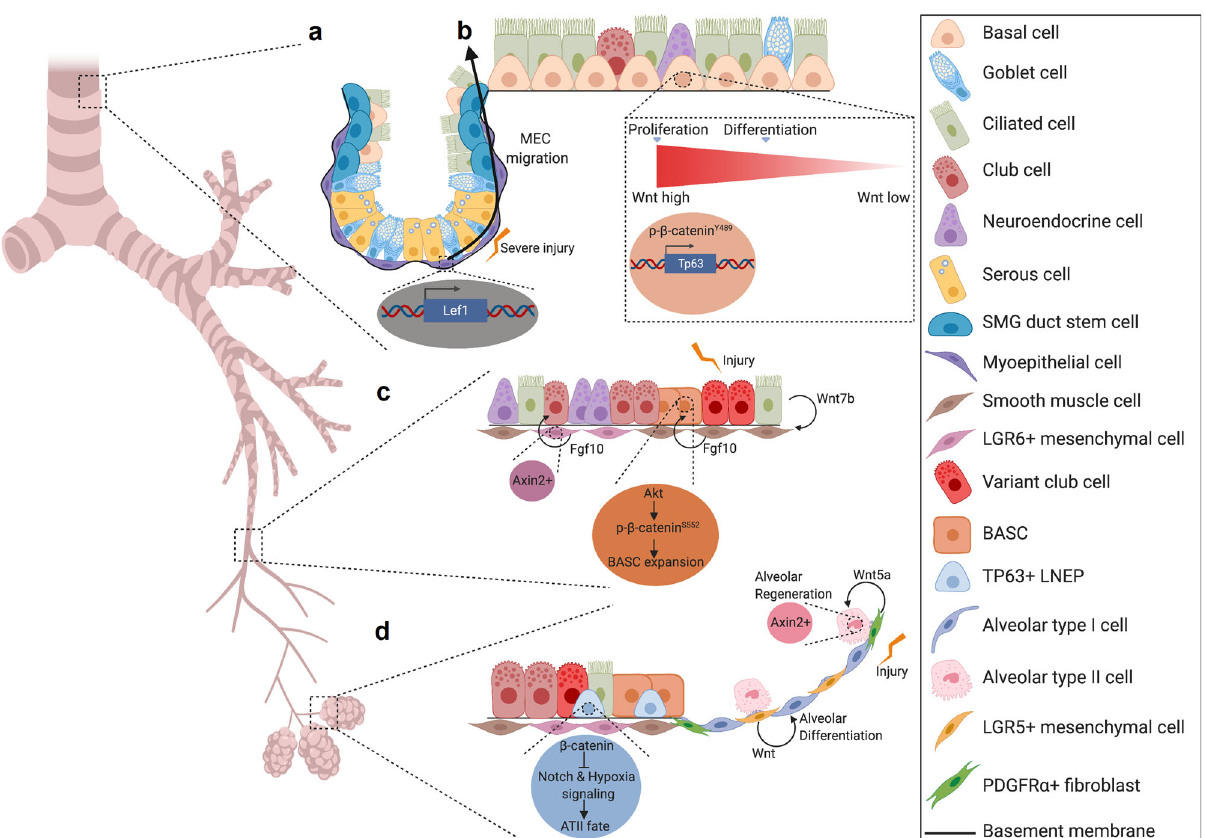
Fig. 3 Wnt signaling plays pivotal roles in submucosal gland, proximal airway, bronchiolar, and distal lung regeneration. a Following severe injury, Lef1 transcription within MECs of the SMGs promotes their migration to the surface airway epithelium and their subsequent ability to give rise to the differentiated cell types of the proximal airway 48,51 . b In the proximal airway ABSCs employ high levels of Wnt signaling to facilitate proliferation and medium levels of Wnt signaling to promote differentiation to the ciliated cell fate. At the molecular level, this appears to be accomplished by nuclear localization of p- β -catenin Y489 65 . Further, Tp63 is regulated by upstream Wnt signaling to promote basal cell stemness, thereby inhibiting differentiation to ciliated cells 66 . c In the bronchioles after injury, ciliated cells produce Wnt7b ligand that signals to airway smooth muscle cells (SMCs). SMCs then secrete Fgf10 ligand to promote an Akt/p- β -catenin S552 signaling cascade. These events then, in turn, promote BASC expansion 76,77 . Another study identi fi ed that Wnt-responsive (Axin2 + ) Lgr6 + mesenchymal cells are a key source of Fgf10 ligand to promote bronchiolar repair 81 . d At the bronchioalveolar duct junction, LNEPs employ β -catenin signaling to inhibit Notch and hypoxia signaling that is permissive for formation of an ATII-like cell fate 80 . Further, Lgr5 + mesenchymal cells secrete Wnt ligands that promote alveolar differentiation 81 . In the alveolus, Pdgfr α + fi broblasts are also a key source of Wnt5a to signal to Axin2 + ATII cells to drive alveolar regeneration 83